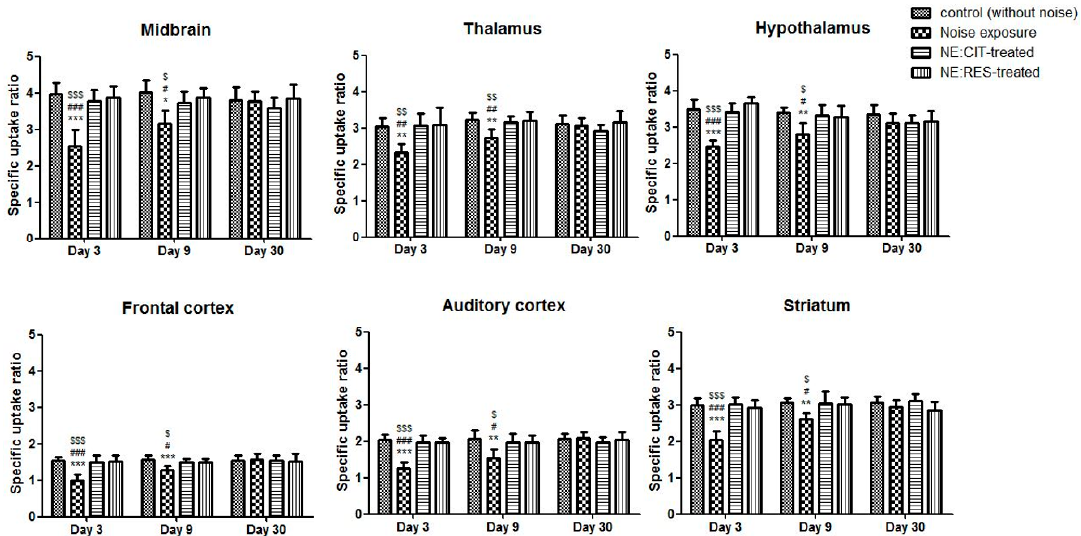
Figure 3. The graphs portray the SURs of 4-[ 18 F]-ADAM/micro-PET on days 3, 9, and 30 in six brain regions. The SURs of 4-[ 18 F]-ADAM were significantly lower in the NE group compared with the control group and the CIT-/RES-treated groups on days 3 and 9. There were no significant differences among the groups on day 30. * p < 0.05, ** p < 0.01, *** p < 0.001 for comparisons between the control group and NE group; $ p < 0.05, $$ p < 0.01, $$$ p < 0.001 for comparisons between the NE group and CIT-treated group; # p < 0.05, ## p < 0.01, ### p < 0.001 for comparisons between the RES-treated group and NE group. (SUR: specific uptake ratio, CIT: citalopram, RES: resveratrol, NE: noise exposure).